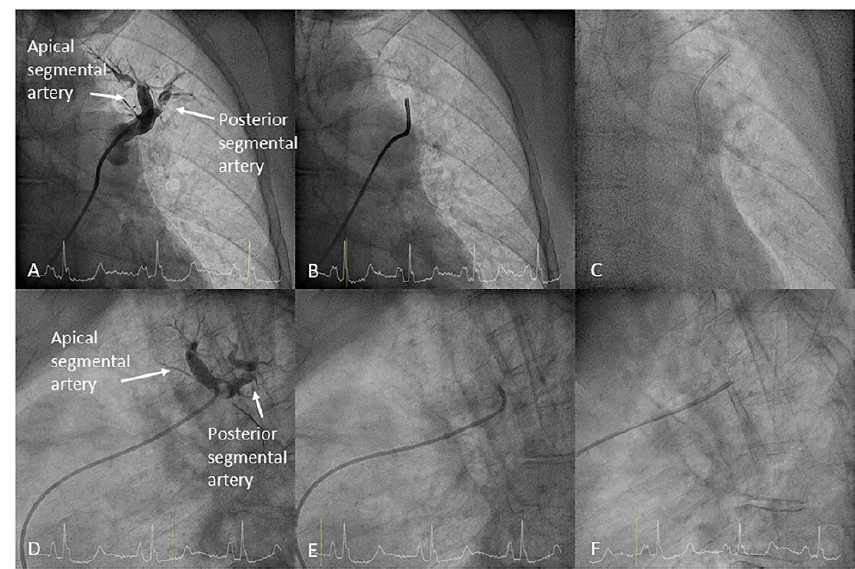
Figure 23. MP catheter positions in the anteroposterior ( A ) (upper row) and lateral views ( B ) (lower row) to cannulate the ( D , E ) apical (A1) and ( C , F ) posterior (A2) left upper lobe branches.